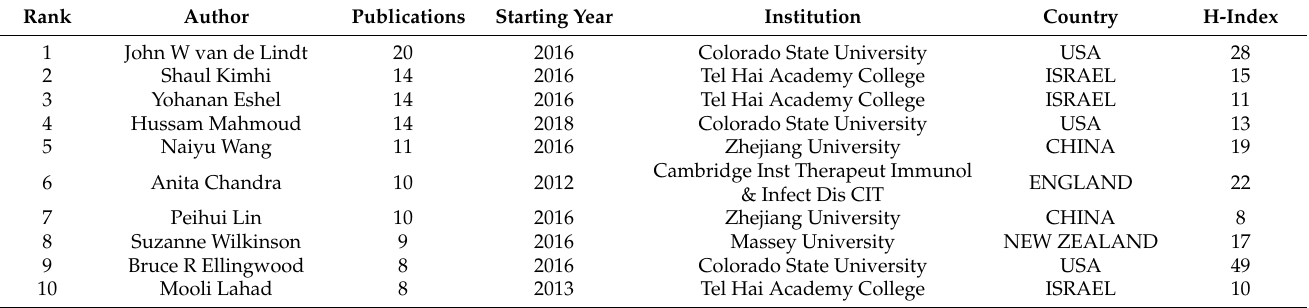
Figure 8. Visualization map of main author cooperation network in community resilience research from 2001 to 2020. The size of the circle refers to the number of articles published by the author. Table 5. Top 10 productive authors in community resilience research from 2001 to 2020. Note that the starting year represents the year when the article was first